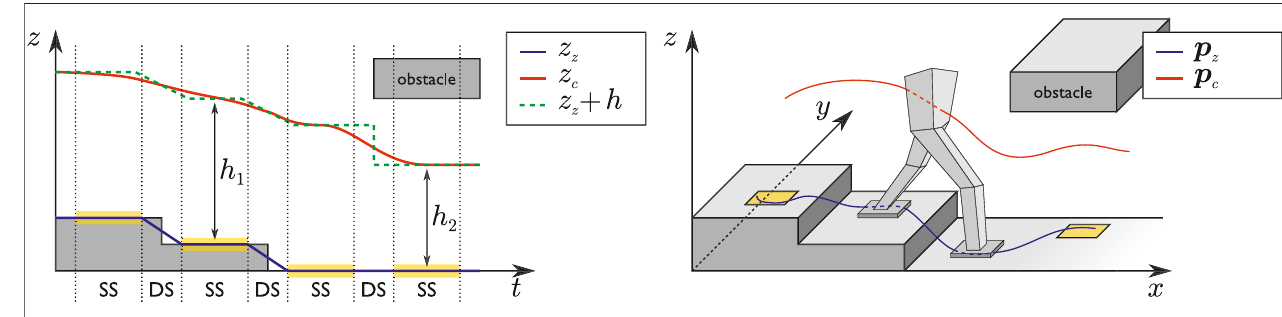
FIGURE4| Left:aqualitativerepresentationofthe fi naltrajectoriesafterQP- z issolvedinanexamplecase.Here,thereferenceCoM/ZMPdistanceiskeptconstant for the initial 3 steps and then lowered in order to pass below an obstacle. Right: a qualitative representation of the trajectories generated after QP- xy is solved.